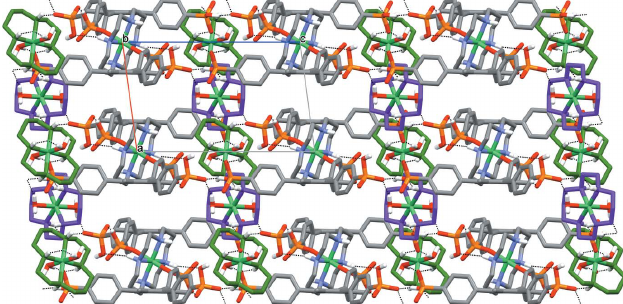
Figure 3 The structure of I viewed down the b axis. C-bound H atoms have been omitted; C and N atoms of the macrocyclic cation formed by Ni2 and Ni3 are shown in green and violet, respectively. Water molecules of crystallization are not shown; hydrogen bonds are depicted as dashed